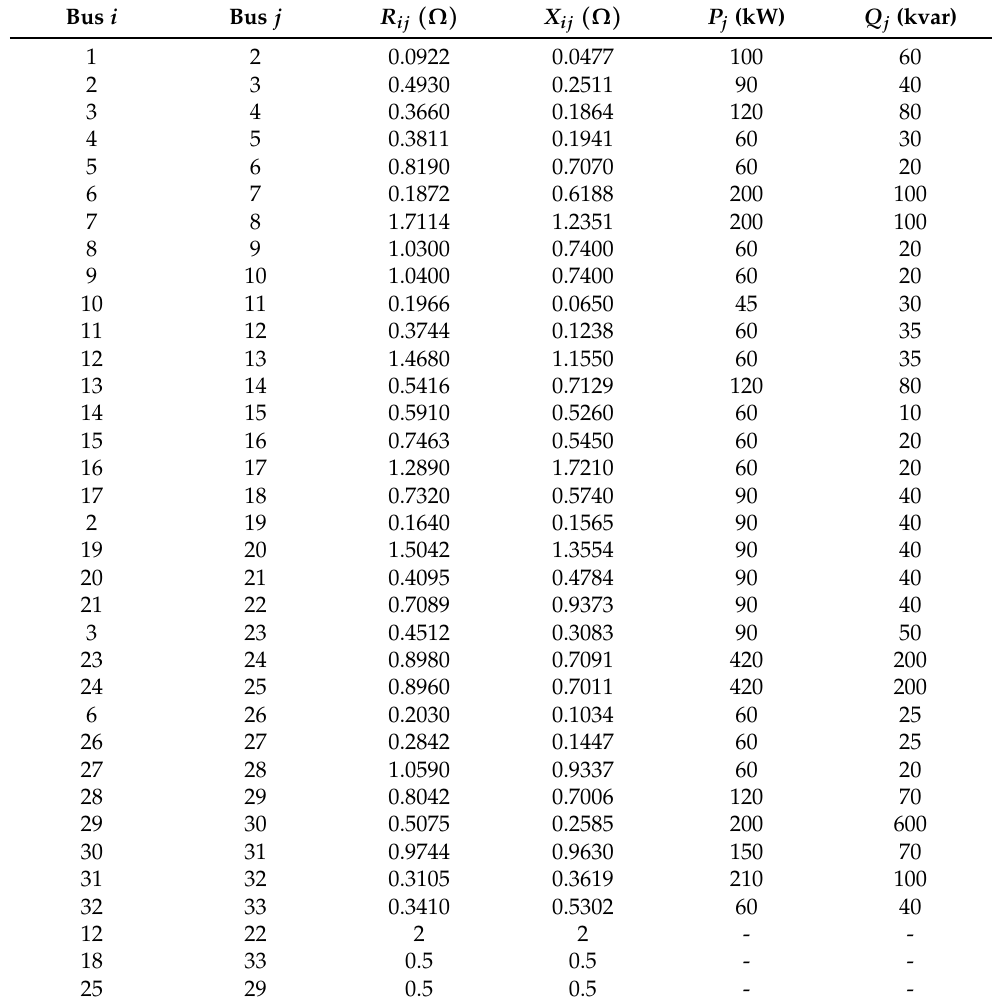
Table 1. Parametric information of the IEEE 33-bus grid with radial and meshed configurations.